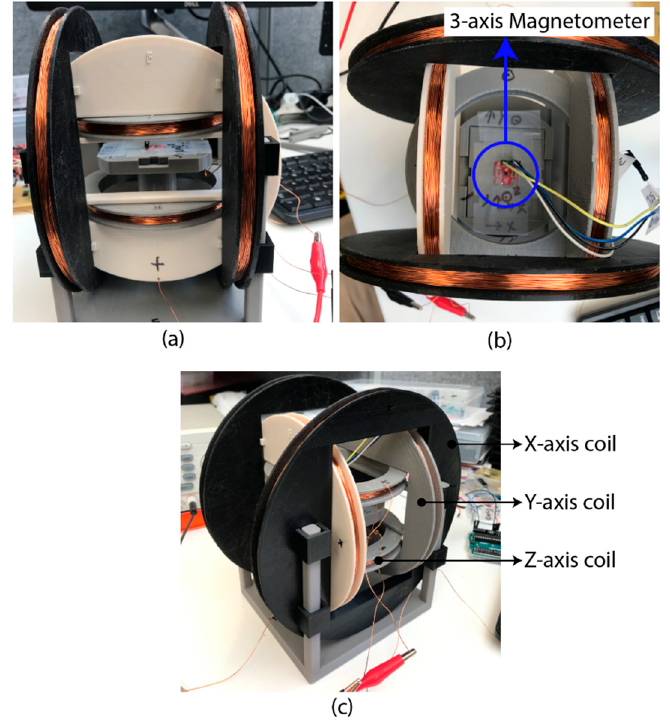
Figure A2. 3-aixs Helmholtz magnetic coil. ( a ) side view; ( b ) top view indicating the 3-axis magne- tometer mounted for calibration; ( b ) front view; ( c ) isometric view.